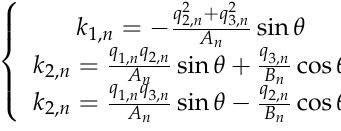
Figure 4. Cross-sectional dimension of each measuring point layer.